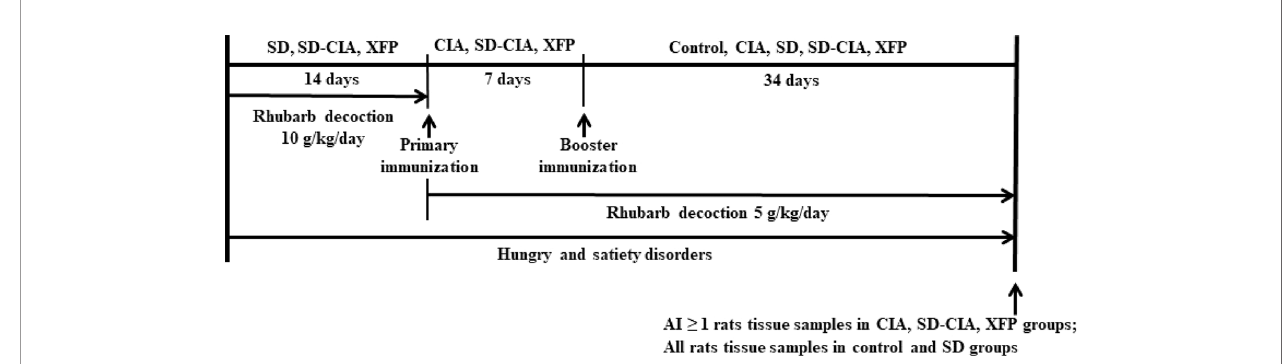
FIGURE 1 | Experimental schedule. Male Sprague – Dawley rats were divided into the control, CIA, SD, SD-CIA, and XFP groups. The SD, SD-CIA, and XFP groups were administered Rheum of fi cinale Baill. decoction at 10 g/kg/day in the fi rst 2 weeks and at 5 g/kg/day until being sacri fi ced. In addition, these three groups were treated with irregular eating from the beginning to the end of this experiment. Next, the CIA, SD-CIA, and XFP groups were immunized with an intradermal injection of 50 µg of IFA-emulsi fi ed bovine type II collagen on the base of the tail twice at 7-day intervals. Control group and SD group were given the same amount of normal saline by the same method. Then, the control, CIA, SD, SD-CIA, and XFP groups were intragastrically administered treatment for 34 days. At the end of the experiment, tissue samples were collected from control and SD group rats with an AI ≥ 1 in the other groups. CIA, collagen-induced arthritis; SD, spleen de fi ciency; SD-CIA, collagen-induced arthritis with spleen de fi ciency; XFP, Xiong Fu powder; AI, arthritis index; IFA, incomplete Freund ’ s